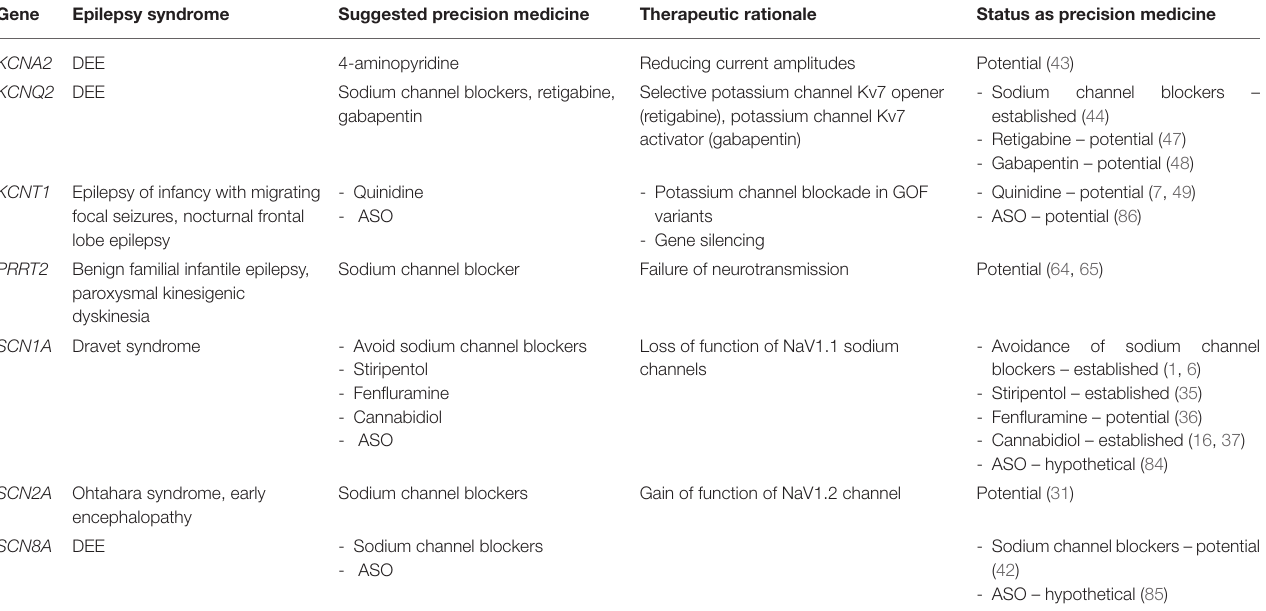
TABLE 3 | Precision therapies for